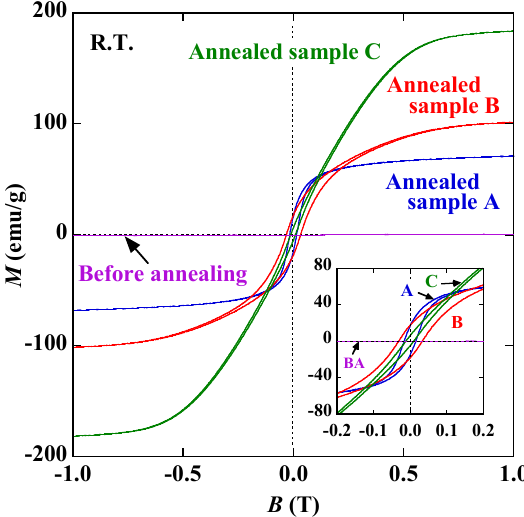
Figure 6. Room temperature magnetization curves of as-produced wires (before annealing (BA)) and samples A, B and C. Inset shows curves enlarged between − 0.2 and 0.2 T.